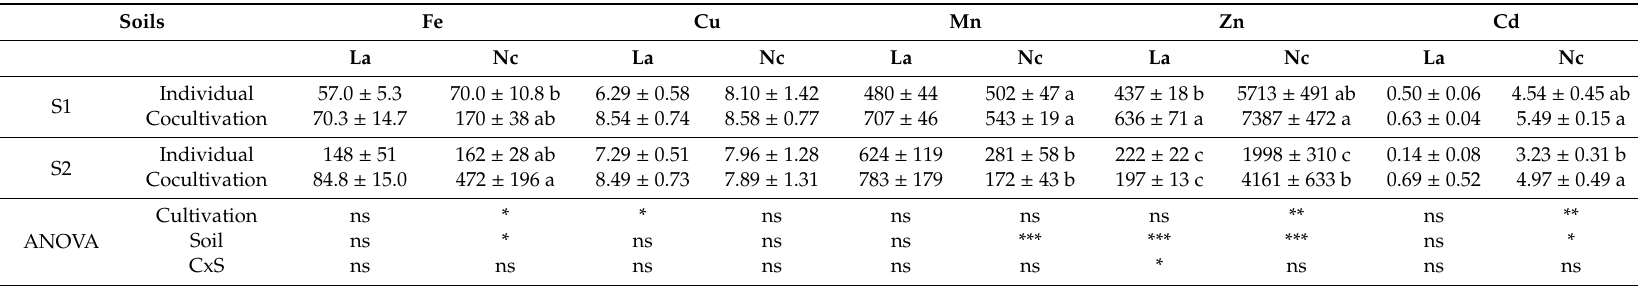
Table 5. Heavy metal concentrations in the plants (aerial part) from Experiment 2 ( µ g g − 1 DW), L. albus (La) and N. caerulescens (Nc), under individual cultivation and cocultivation (n =